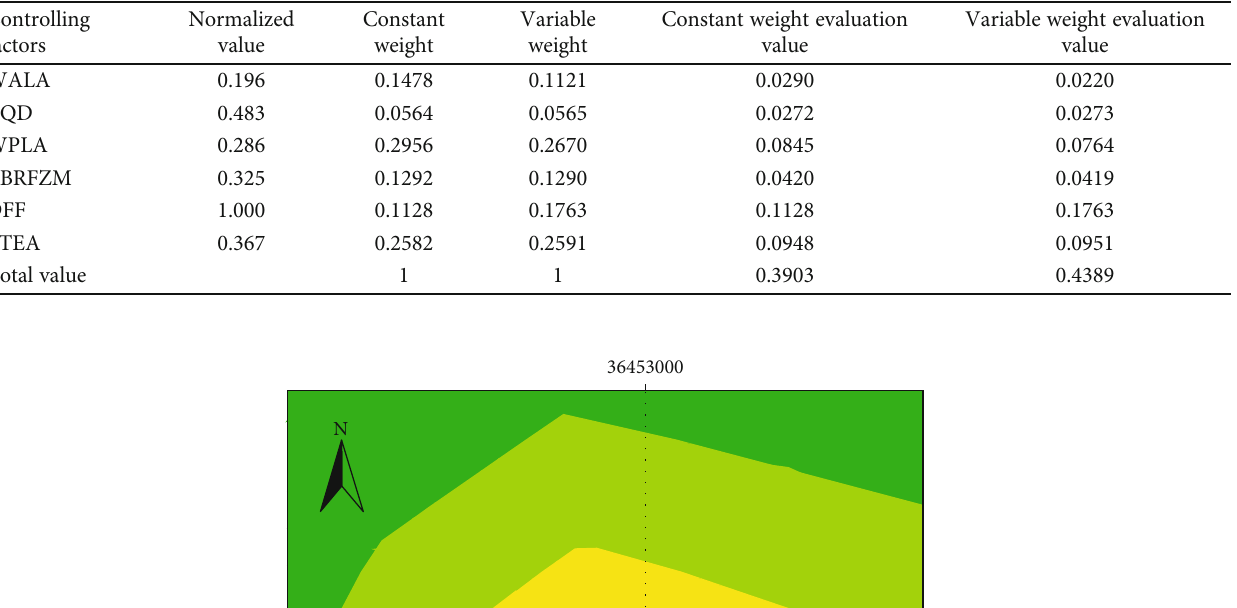
Table 2: Comparison of typical unit evaluation results.